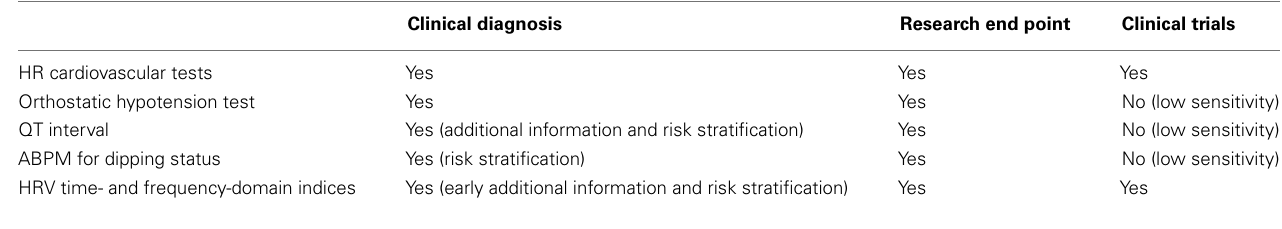
Table 2 | Cardiovascular autonomic tests and suggested indications for their